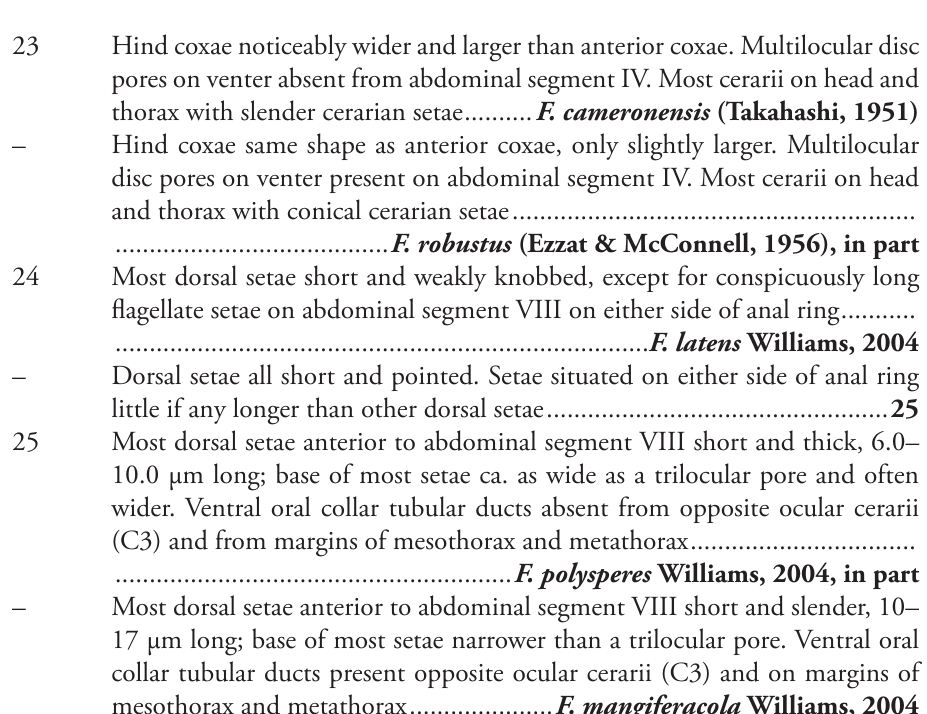
10.0 µm long; base of most setae ca. as wide as a trilocular pore and often wider. Ventral oral collar tubular ducts absent from opposite ocular